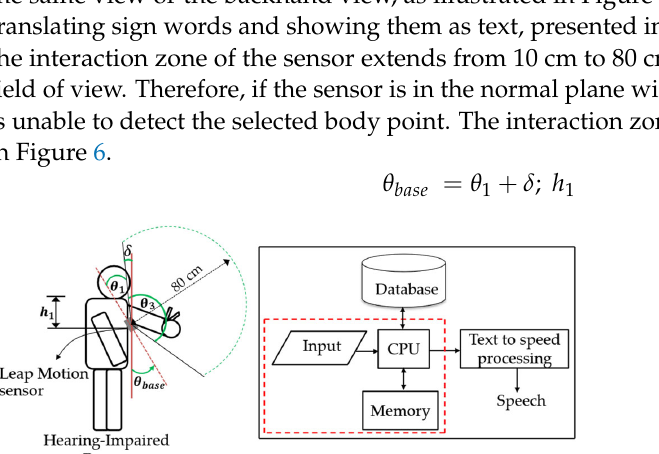
Figure 6. Hardware system.